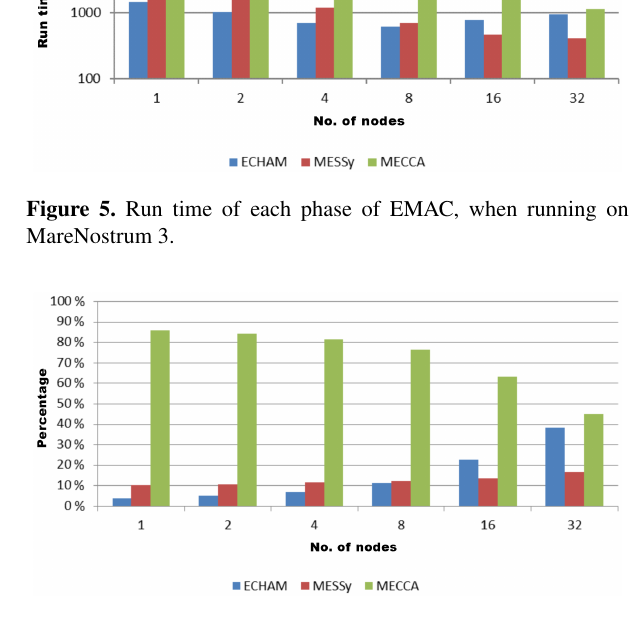
Figure 6. Percentage of run time of each phase of EMAC, when running on MareNostrum